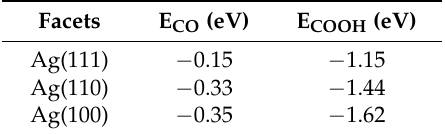
Table 1. The binding energy of COOH and CO on Ag